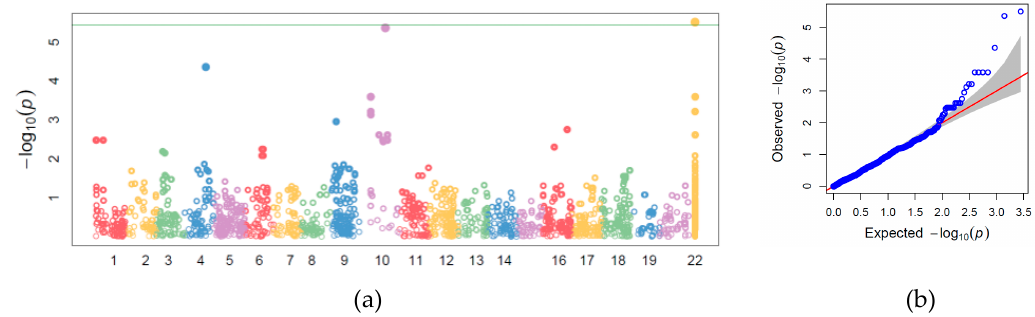
Figure 4. Marker–trait associations for maturity class (MC) ( a ) Manhattan plot, where the green line represents the Bonferroni-corrected significance level. The X-axis describes the chromosome numbers (1 = 1C, 2 = 2C, 3 = 3C, 4 = 4C, 5 = 5C, 6 = 6C, 7 = 7C − 17A, 8 = 8A, 9 = 9D, 10 = 10D, 11 = 11A, 12 = 12D, 13 = 13A, 14 = 14D, 15 = 15A, 16 = 16A, 18 = 18D, 19 = 19A, 20 = 20D, 21 = 21D and 22 = unmapped); ( b ) This q–q plot shows the distributions of observed and expected –log( p -values). Significant associations are the three highest values.